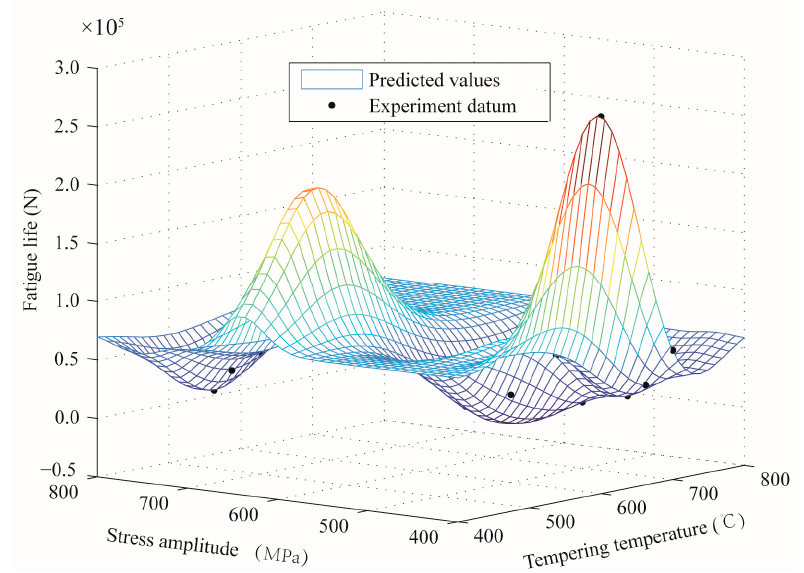
Figure 8. The predicted surface of mean fatigue life based on the kriging model.